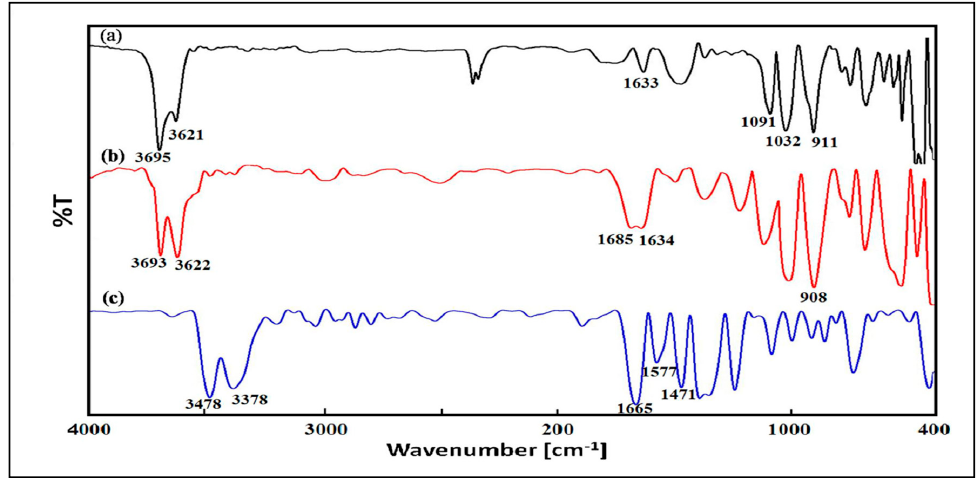
Figure 3. FTIR spectrum of ( a ) Halloysite nanotubes (HNTs); ( b ) Chlorhexidine loaded Halloysite nanotubes (HNT/CHX); ( c ) Chlorhexidine (CHX).